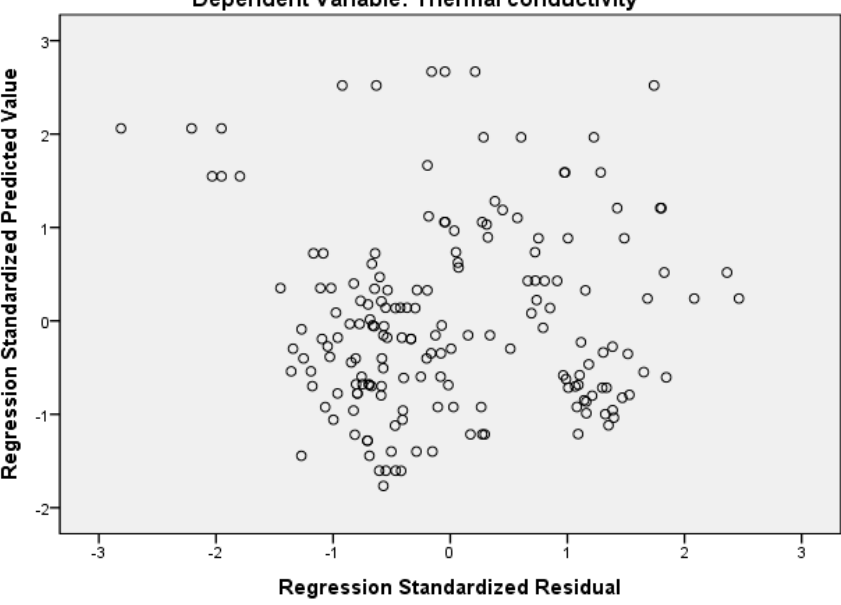
Figure 6. Homoscedasticity plot of residuals.